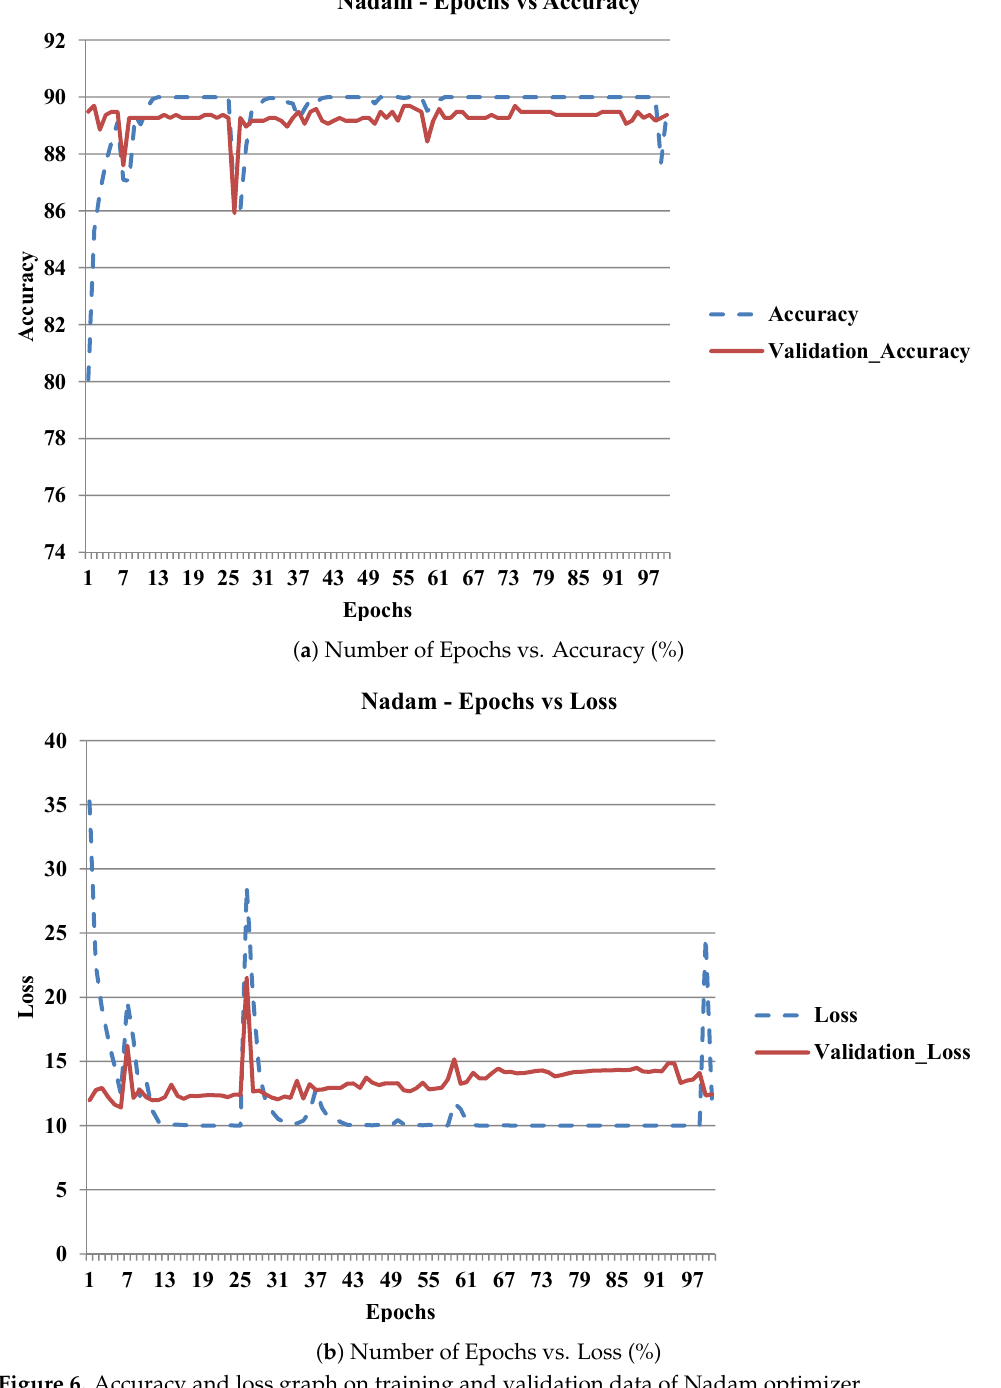
Figure 6. Accuracy and loss graph on training and validation data of Nadam optimizer. RMSprop: RMSprop is an unpublished, adaptive learning rate algorithm; however, [37] shows its popularity until 2017 and it remains popular now. It uses the magnitude of recent gradients to normalize the gradients. Figure 7a shows a plot of the number of epochs vs. accuracy (%) based on the observation of 100 epochs of the RMSprop optimizer. Figure 7b shows a plot of the number of epochs vs. accuracy (%) observed for 100 epochs of the RMSprop optimizer. Unfortunately, both accuracy and loss were not saturated up to 100